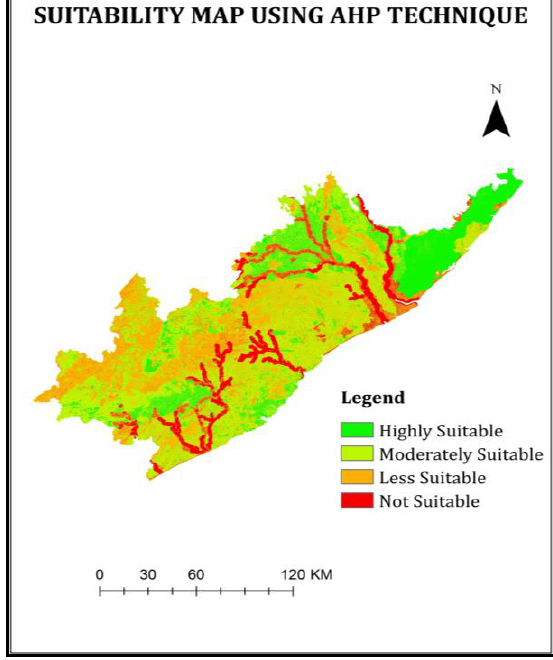
Fig 8: Suitability map to establish industries using AHP